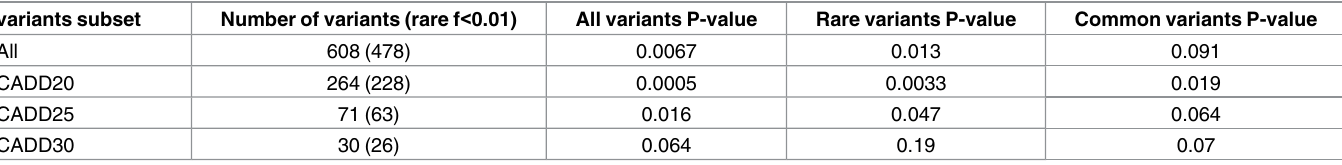
Table 3. DCM gene set association analysis variants